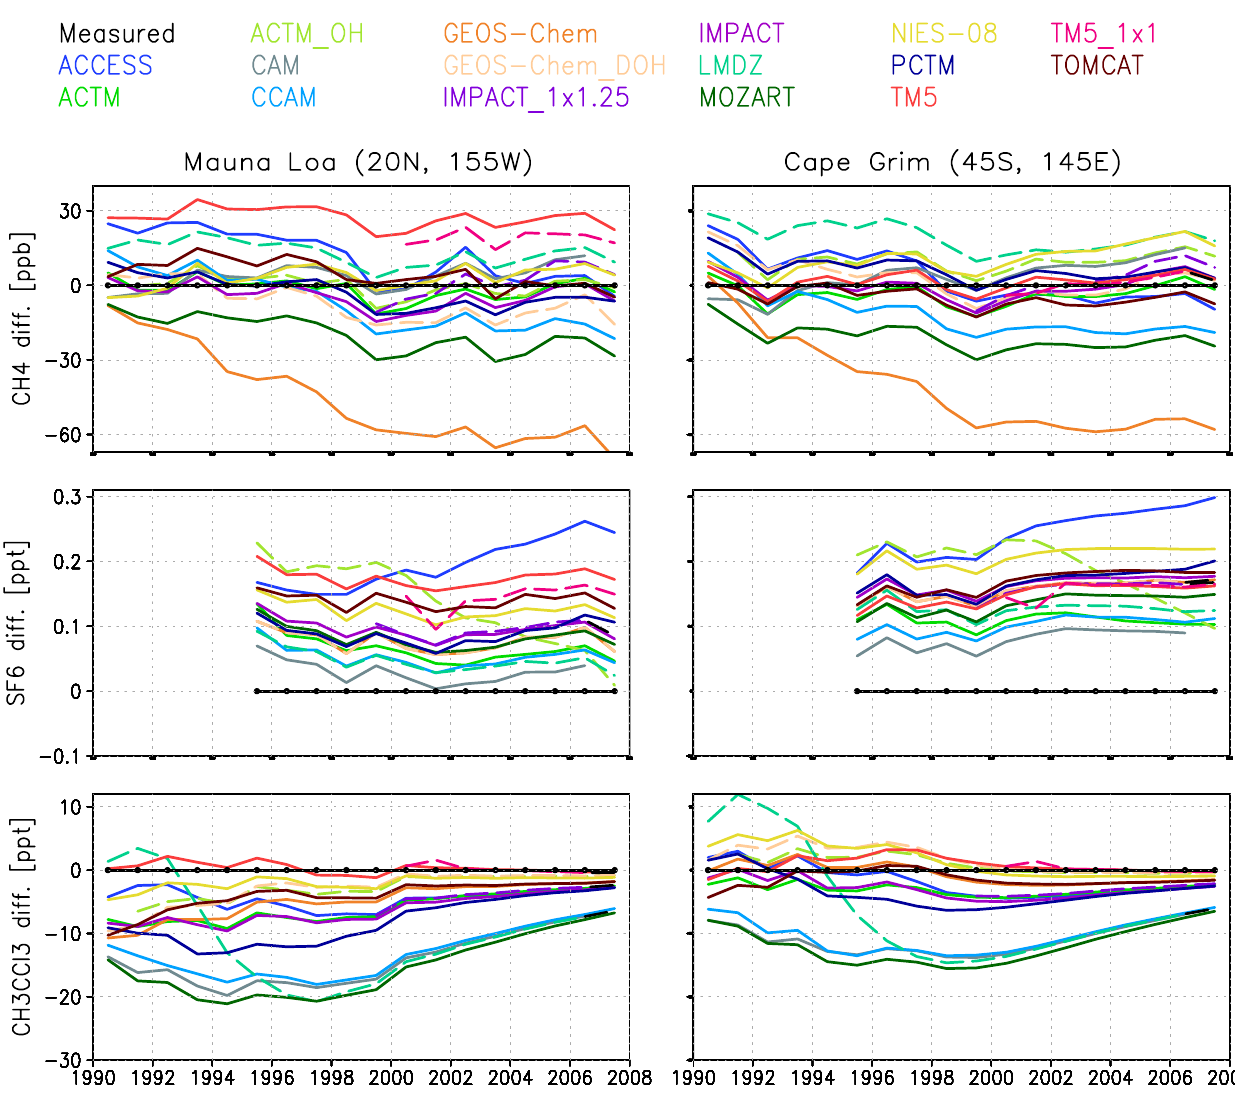
Fig. 4. Time series of differences between observed and simulated annual mean CH 4 in CH 4 CTL scenario (top row), SF 6 (middle row) and CH 3 CCl 3 (bottom row) at two selected sites: MLO (left column) and CGO (right column). Time series of annual mean values and tropospheric model values, averaged over 1000–200mb and all latitudes/longitudes, are shown in Figs. S18 and S19,